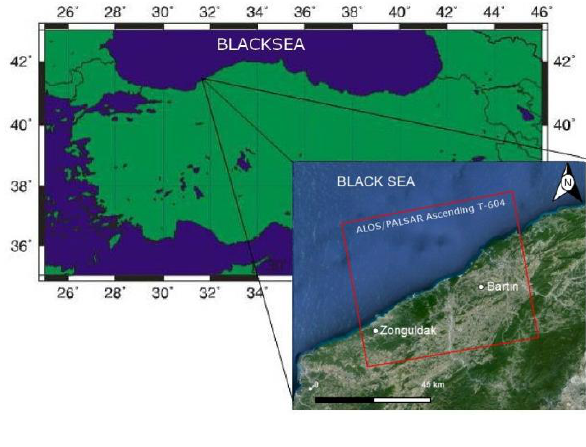
Figure 1. Study area